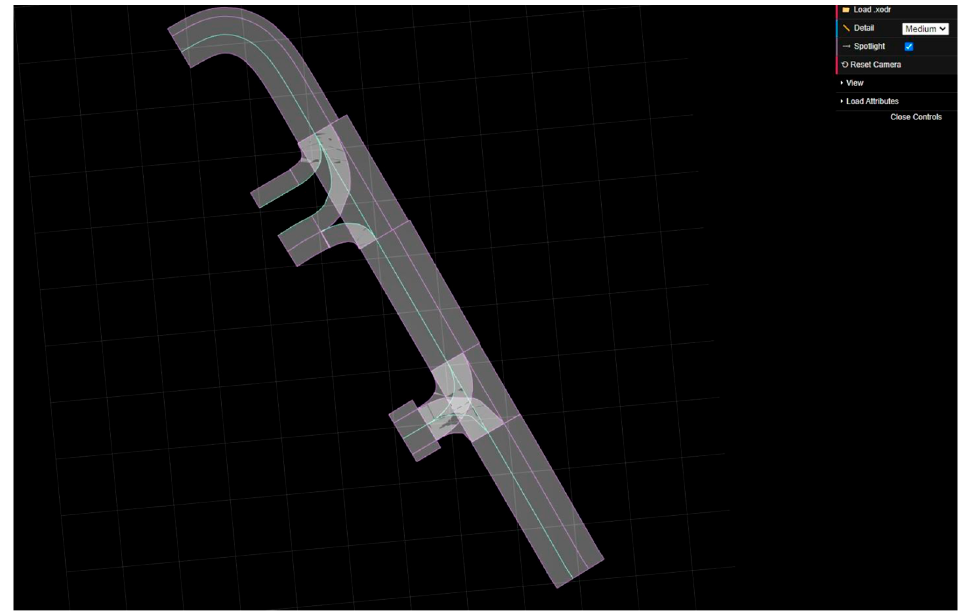
Figure 10. Results presented in OpenDRIVE Online Viewer.